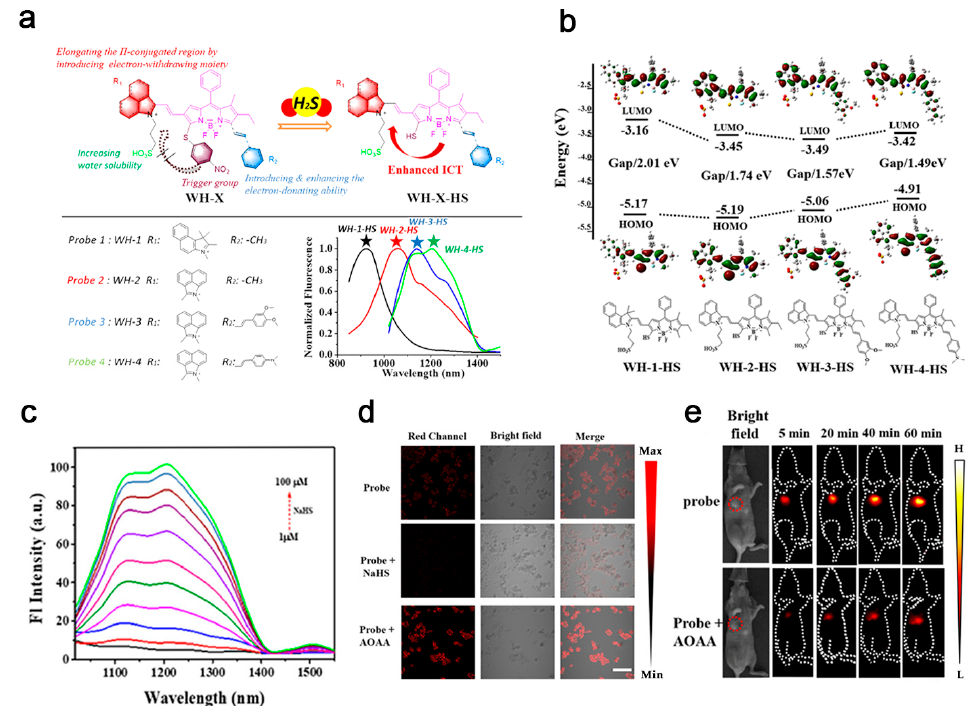
Figure 7. ( a ) Schematic illustration of the construction of several H 2 S-activatable NIR-II fluorescence probes WH-X (WH-1, WH-2, WH-3, and WH-4). ( b ) Theoretical calculations used to verify the design strategy. The HOMO and LUMO energy levels of WH-X-HS were computed. ( c ) Fluorescence spectra of WH-4 in the presence of different concentrations of NaHS under the irradiation of 980 nm laser. ( d ) Intracellular fluorescence imaging of HCT-116 cells incubated with WH-3, WH-3 + NaHS, and WH-3 + AOAA. ( e ) NIR-II fluorescence imaging of tumor-bearing mice at various time points after treatment with WH-3 and WH-3 + AOAA. Reproduced with permission [121]. Copyright 2021, American Chemical Society.